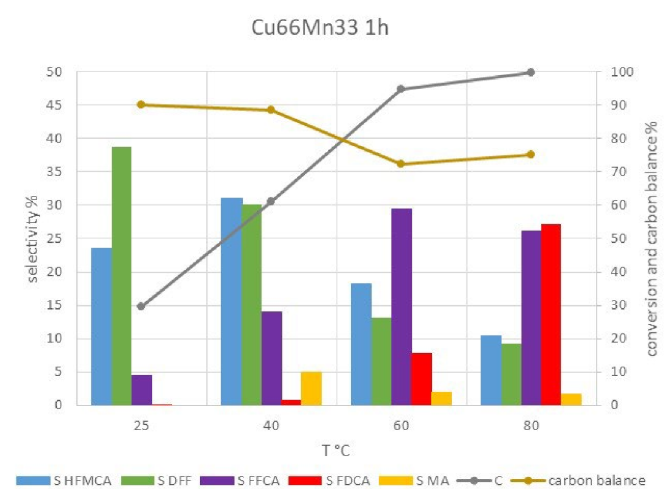
Figure 10. Conversion, selectivity, and carbon balance on catalyst Cu67Mn33 as a function of the temperature of the reaction. The lines are a guide for the eye. Reaction conditions: TBHP/HMF 7 (molar ratio), HMF/catalyst 4 ( w / w ), 1